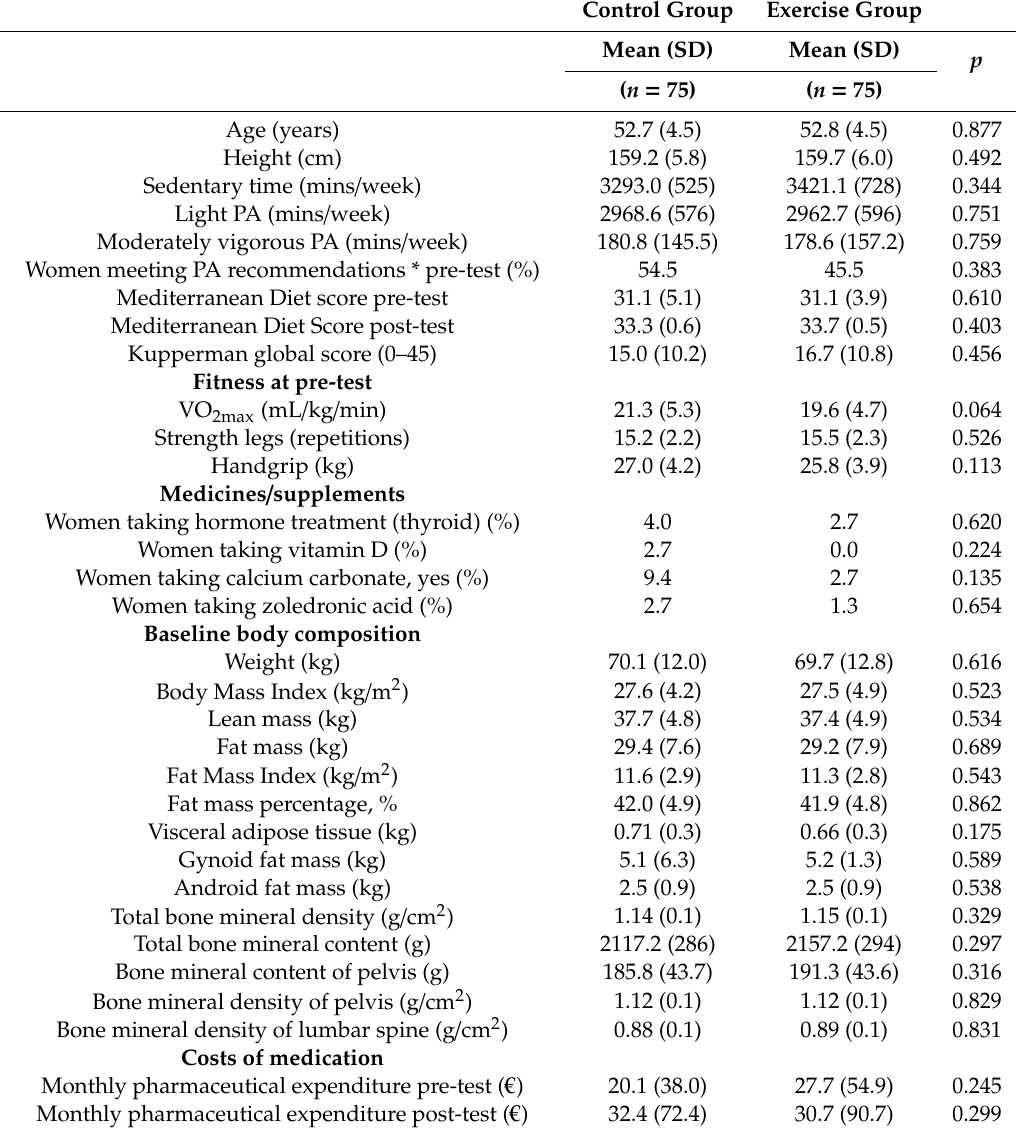
Table 1. Baseline characteristics of the study